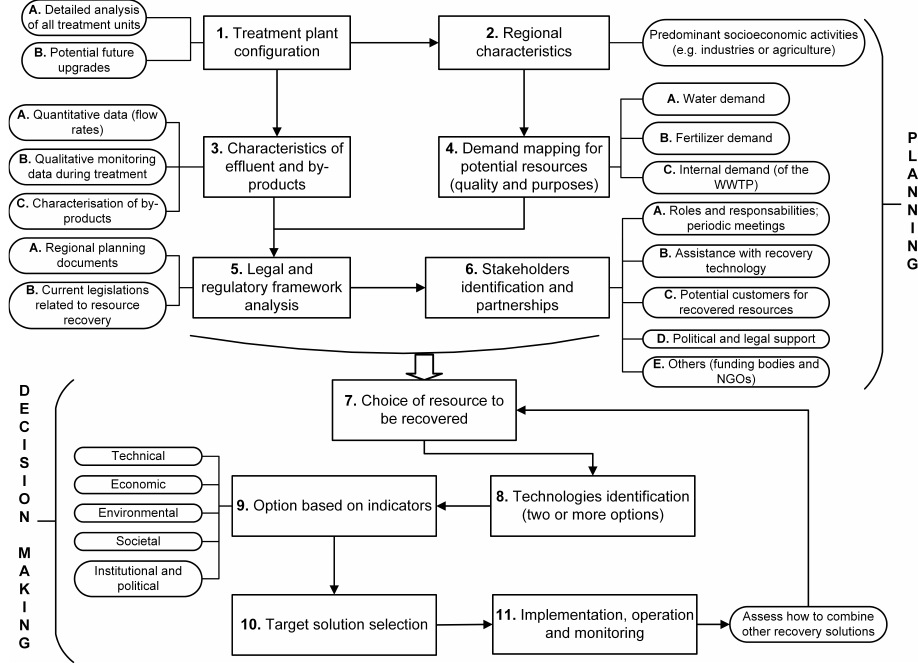
Figure 1. Framework applied in this study (adapted from [31]). Table 2. Indication of the framework applicability in megacities similar to S ã o Paulo (New York is shown for comparison